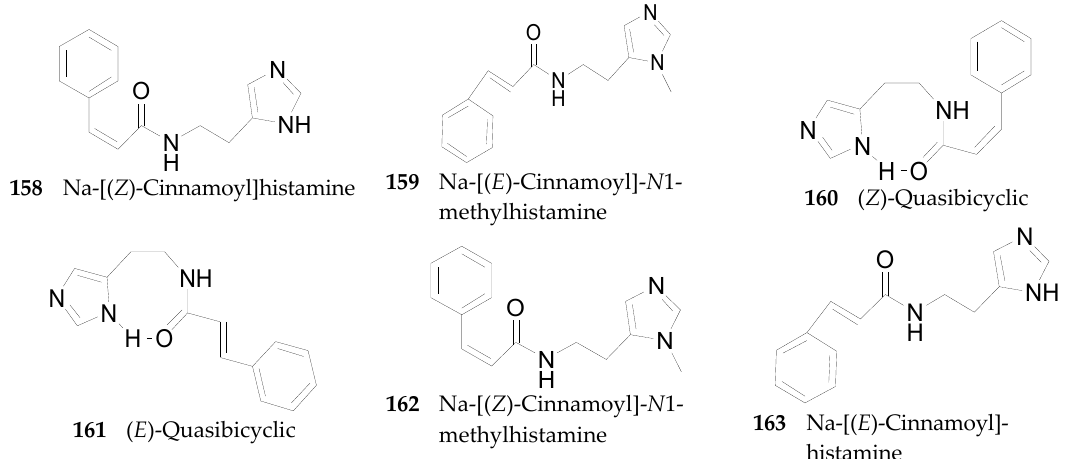
Figure 10. Chemical structures of compounds 158 – 163 .